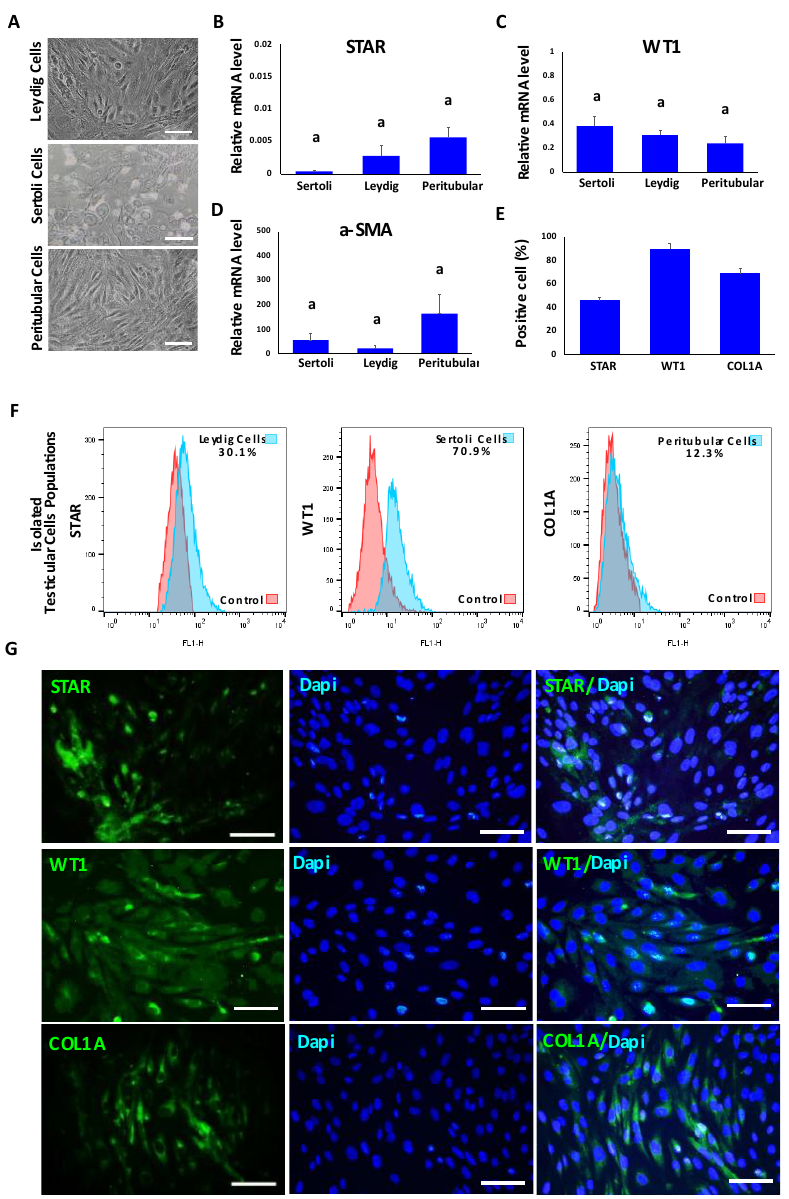
Figure 1. Characterization of primary bovine testicular cell types including Leydig, Sertoli and peritubular myoid cells used for TO formation. ( A ) Phase contrast representative images of Leydig, Sertoli and peritubular myoid primary cell cultures. ( B – D ) Gene expression analysis of STAR (Leydig cells), WT1 (Sertoli cells) and α -SMA (peritubular myoid cells) detected no significant differences among cell cultures. Data were expressed as the mean ± SEM ( n = 3). ( E ) Percentages of STAR, WT1 and COL1A immune-positive cells in respective Leydig, Sertoli and peritubular myoid cell cultures. ( F ) Representative histograms of testicular cell populations positive for each marker: STAR, WT1 and COL1A (Leydig, Sertoli and peritubular cells, respectively). ( G ) Representative immunofluorescence analysis of STAR, WT1 and COL1A markers in Leydig, Sertoli and peritubular myoid cells. Superscript (a) indicates no significant ( p > 0.05) differences in gene expression among cell types. Scale bar = 100 µ